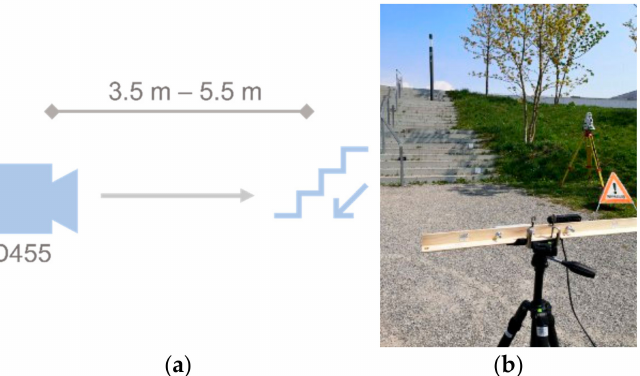
Figure 13. Outdoor experimental setup for the performance evaluation of depth measurements under different lighting conditions: ( a ) schematic view of the experiment; ( b ) illustration of the outdoor test